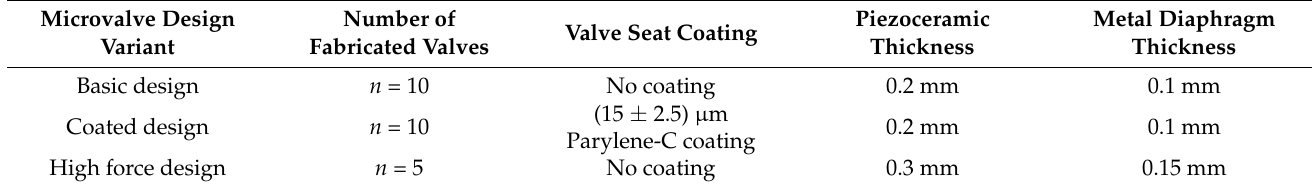
Table 1. Overview on fabricated NO microvalve